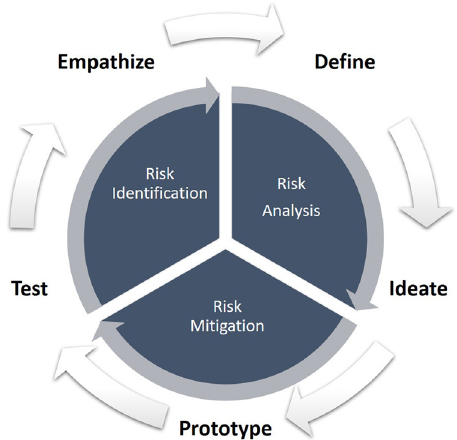
Figure 1: Privacy framework integrated into the design thinking